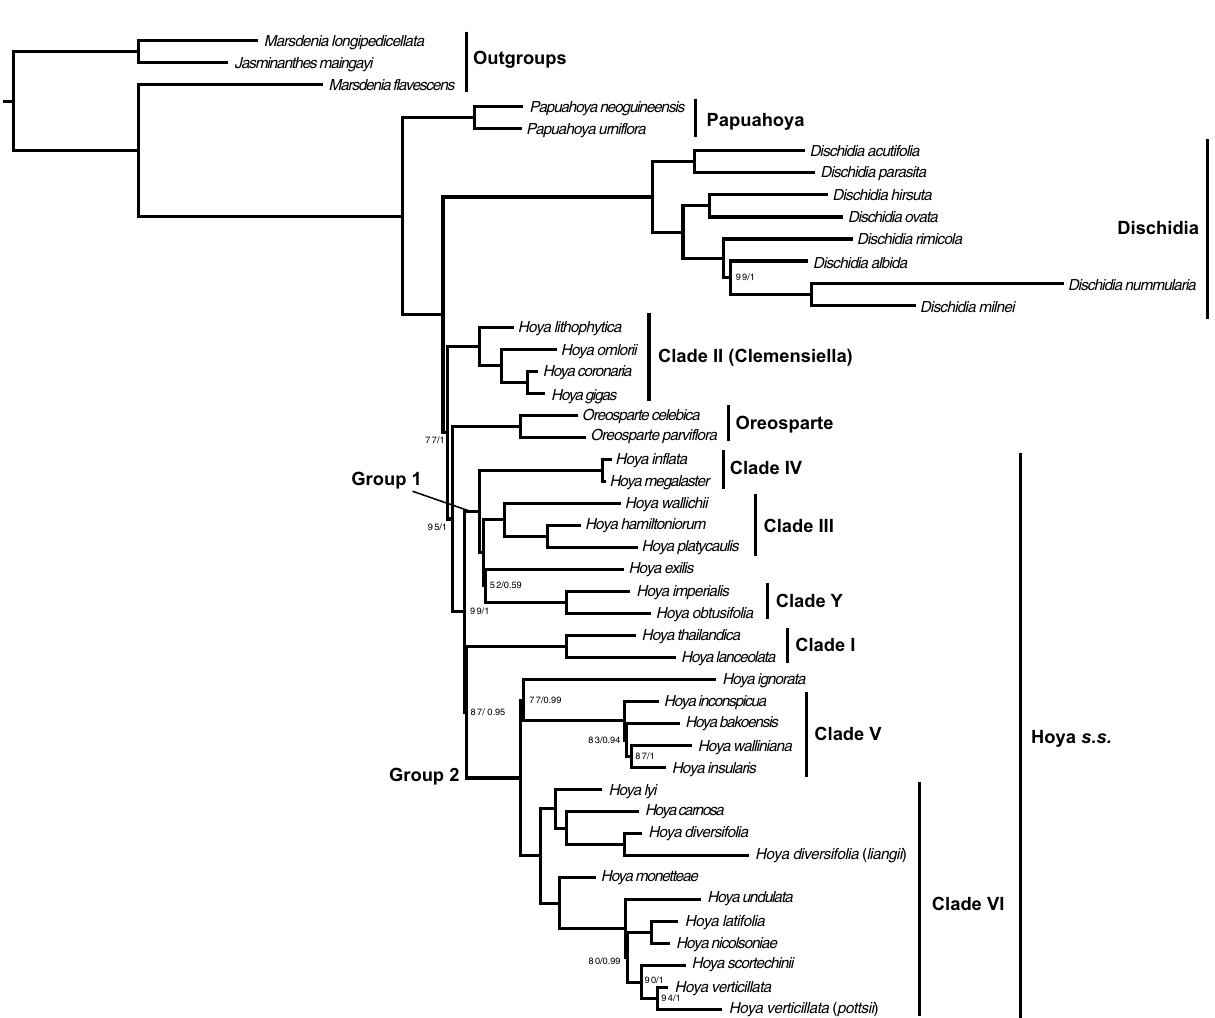
Figure 5. Mauve alignment of available mitogenomes in Apocynaceae, showing massive restructuring. ( Hoya lithophytica on the top, Asclepias syriaca below). Corresponding blocks present in both mitogenomes are indicated by colour.